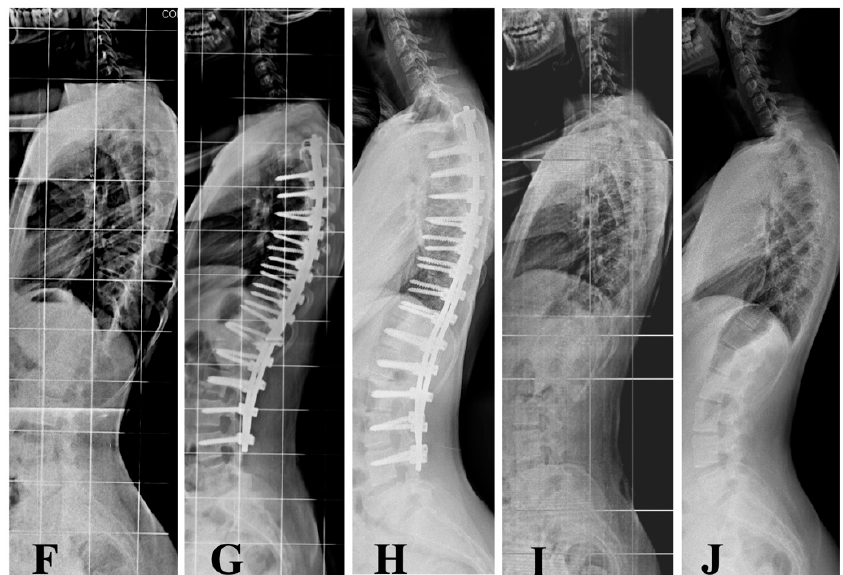
Figure 2. A 13-year-and-2-month-old girl with Lenke type 1BN AIS (50°/36°) with Risser 1 ( A ) and thoracic hypokyphosis of 13° ( F ), was surgically treated by a posterior approach involving T3-L4 instrumentation without fusion with slight hypercorrection of both curves ( B ). Three years and two months after the initial surgical intervention and just before the removal of instrumentation, the main and compensatory curves remained unchanged towards the opposite side of the initial curves ( C ). The radiograph after removal of the vertebral implants shows minimal residual scoliosis towards the opposite side of the curves that existed before surgical treatment ( D ). These minimal scoliotic curves remained unchanged on the last radiograph, taken two years after the removal of the instrumentation ( E ). Concerning the sagittal plane, the postoperative radiograph after surgical correction demonstrated an increase in previous hypokyphosis ( G ), which remained unchanged in the radiograph prior to removal of the instrumentation ( H ), after its removal ( I ), and in the last X-ray check-up two years after instrument removal ( J ).